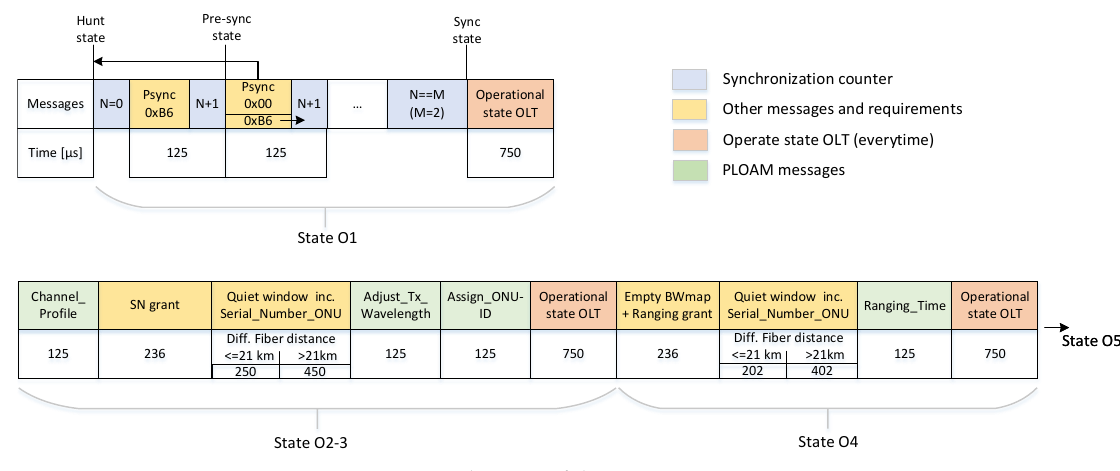
Figure 6. Visualization of the NG-PON2 activation.